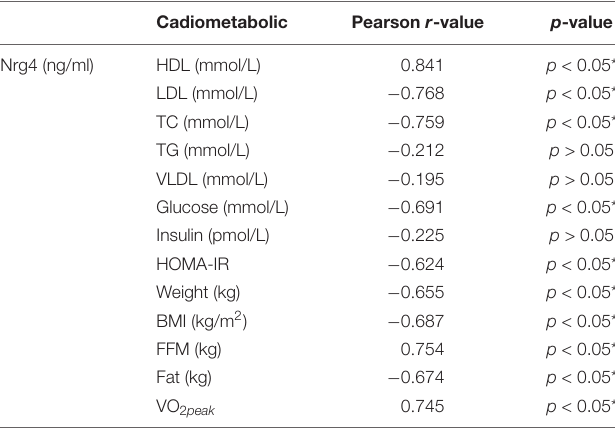
TABLE 4 | Pearson correlation coefficients between Nrg4 and cardiometabolic and body composition variables. Cadiometabolic Pearson r -value p